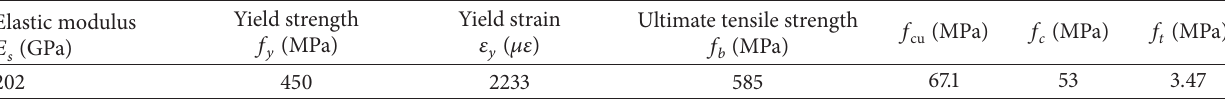
Table 2: Measured material performance data of test